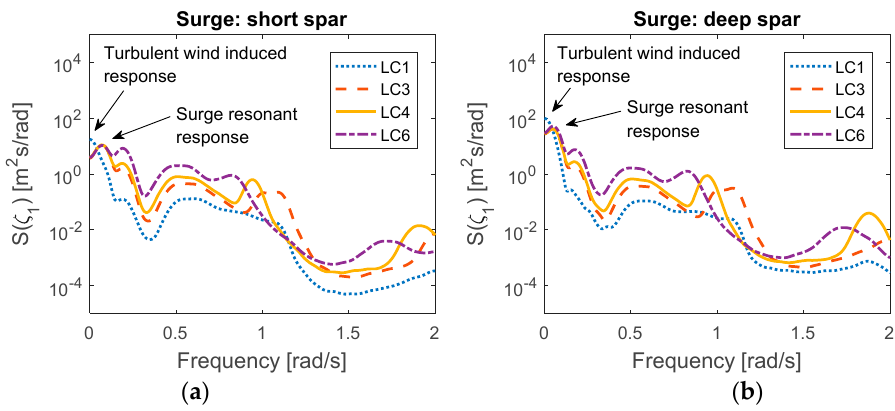
Figure 11. Power spectra in surge under all loading cases: ( a ) Short spar; ( b ) Deep spar.